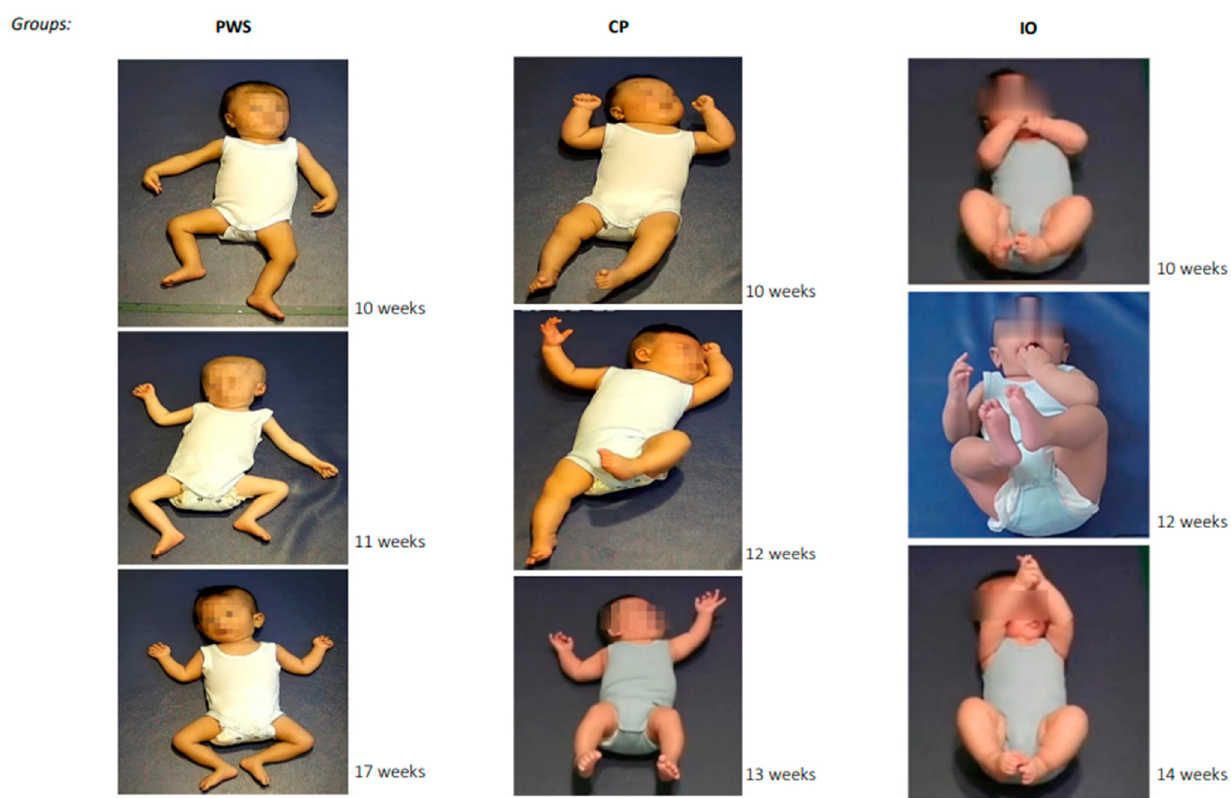
Figure 1. Examples of postural patterns from the Prader-Willi syndrome (PWS), cerebral palsy (CP), and inconspicuous developmental outcomes (IOs) groups, respectively. Three infants are exemplified for each group. Pictures were extracted from the original GMA videos. The infant’s post-term age at the time of GMA is provided next to each picture. The “frog-leg” posture of the lower extremities presented in all the three examples of the PWS group were observed in 13 of the 18 infants in the group. About one-third (7/18) of the infants also presented long-lasting or repetitive “mantis-hand” postures (unilateral or bilateral pronated wrist(s) with extended adducted fingers), as shown on the top example of the PWS group.